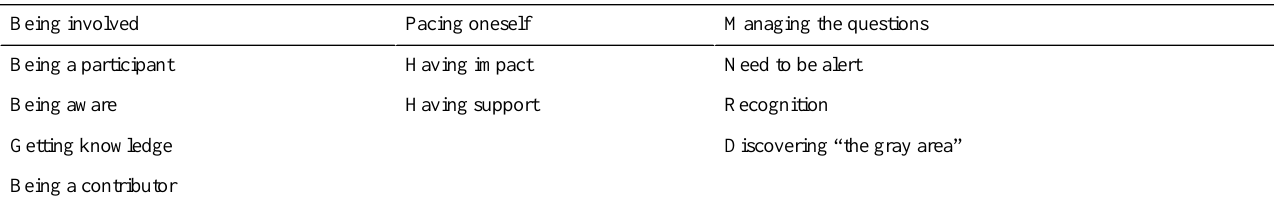
Table 1. Overview of clusters and